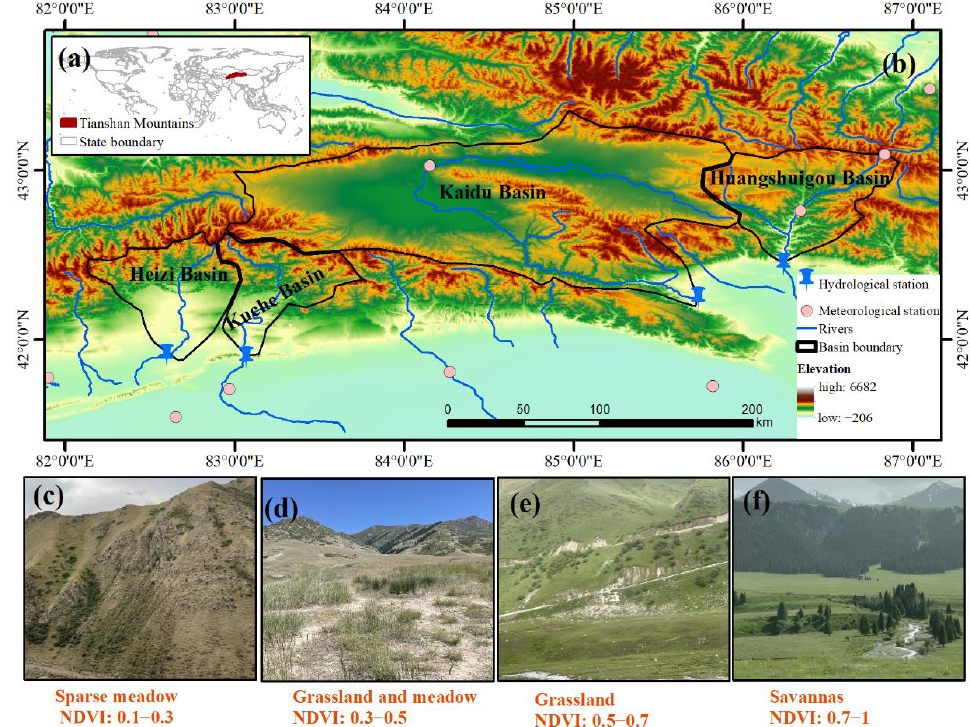
Figure 1. Location of study area and the representative vegetation landscape. The subfigure ( a ) shows the location of Tianshan Mountains in the world; the subfigure ( b ) shows the basic geo- graphic information of the four basins; the subfigures ( c–f ) show the NDVI values under different landscape types.